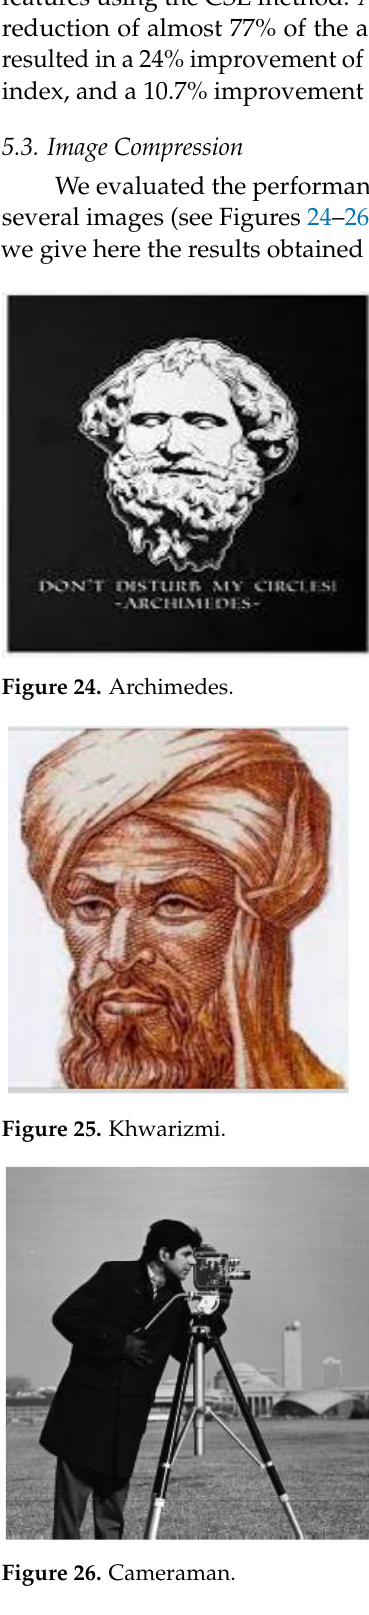
Figure 26. Cameraman. 5.4. Compression Results Figures 27–35 give the images obtained after decompression of the compression re- alized using the algorithms based on GMM, FCM, and FP-Conv-CM. Table 4 gives the values of the performance measures MSE, PSNR, and SSIM of different compressions re- alized with the algorithms that implement GMM, FCM, and FP-Conv-CM. Table 4. MSE, PEAKSNR, and SSIM values associated with the images compressed by FCM, GMM, and FP-Conv-CM. Method